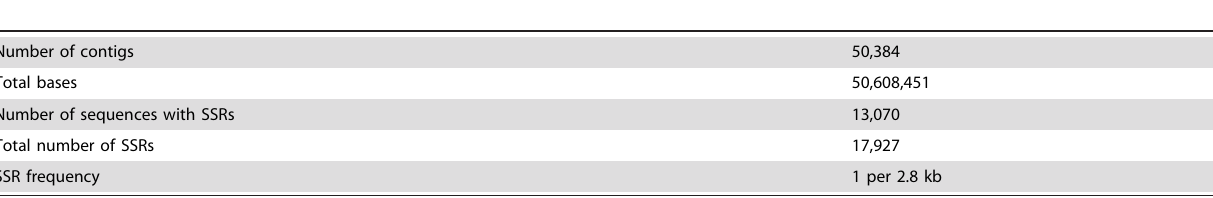
Table 5. Summary of putative SSRs identified using MISA software.